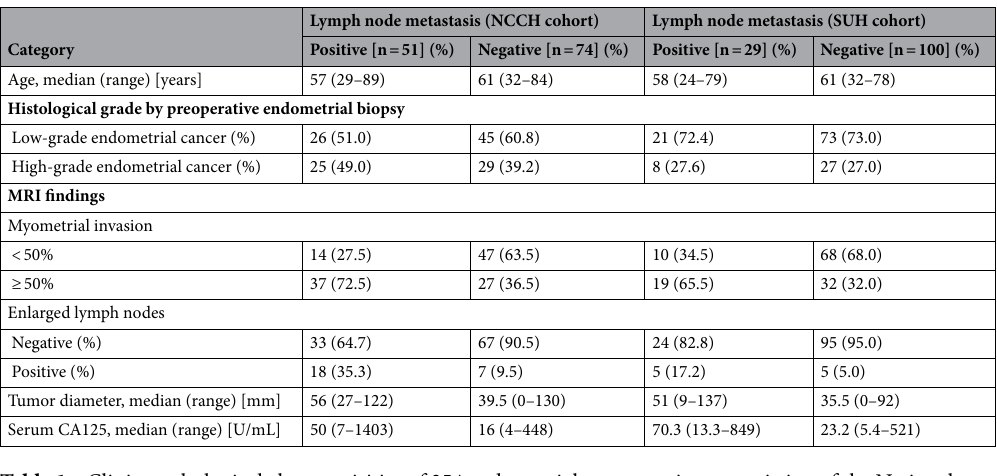
Table 1. Clinicopathological characterisitics of 254 endometrial cancer patients consisting of the National Cancer Center Hospital and the Showa University Hospital cohorts. NCCH National Cancer Center Hospital, SUH Showa University Hospital, MRI Magnetic resonance imaging, CA125 Cancer antigen